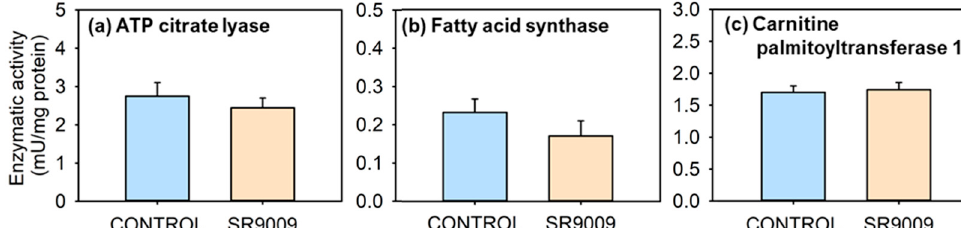
Figure 8. Effect of subchronic treatment SR9009 on the activity of enzymes related to lipid metabolism. Activity of ATP citrate lyase ( a ), fatty acid synthase ( b ), and carnitine palmitoyltransferase 1 ( c ) on the liver of goldfish ( Carassius auratus ) treated with vehicle alone (CONTROL) or containing SR9009 (100 µg/g bw). Data are expressed as mean + S.E.M. ( n = 12/group).